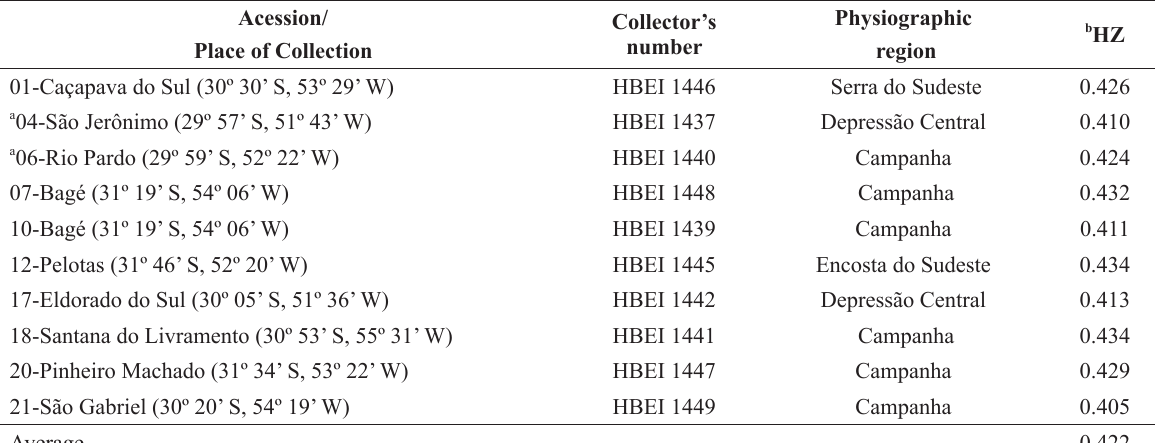
Acessions of T. polymorphum analyzed, collector’s number, physiographic region and expected